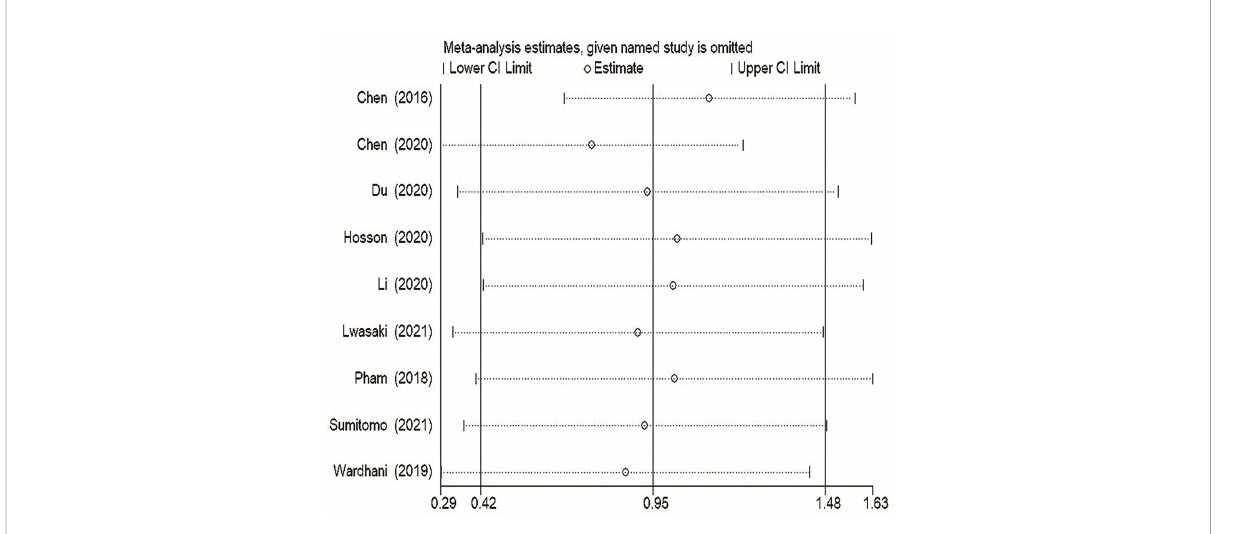
FIGURE 6 Sensitivity analysis of pooled HRs on the association between TDO2 expression and OS. OS, overall